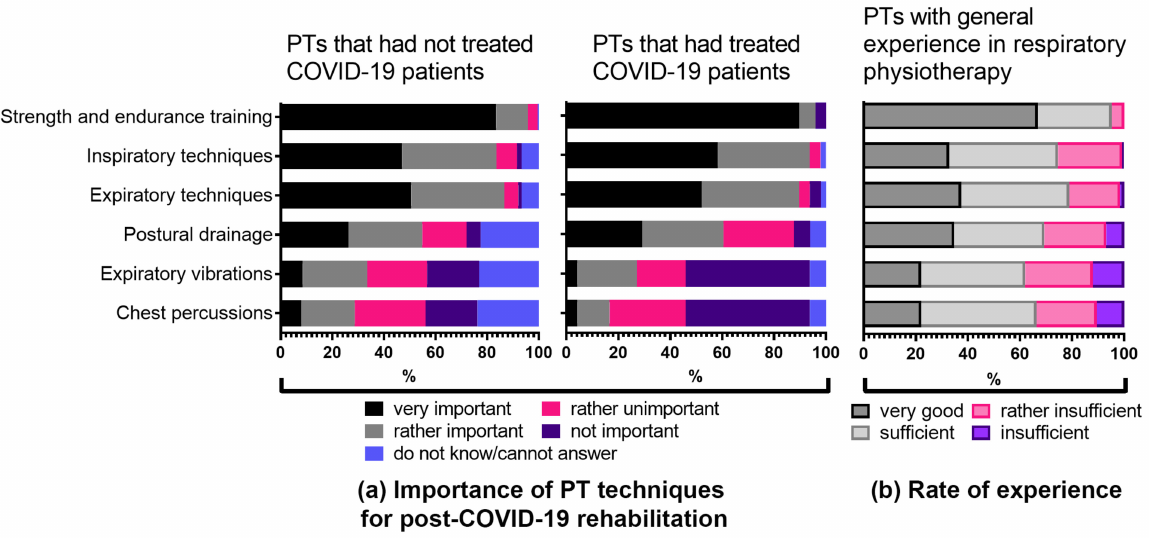
Figure 4. ( a ) Perception of physiotherapists regarding the importance of specific treatment techniques for post-COVID-19 rehabilitation. ( b ) Assessment of experience in specific treatment techniques by physiotherapists with previous experience in respiratory rehabilitation. PT, physiotherapy; PTs, physiotherapists. See also Supplementary PDF